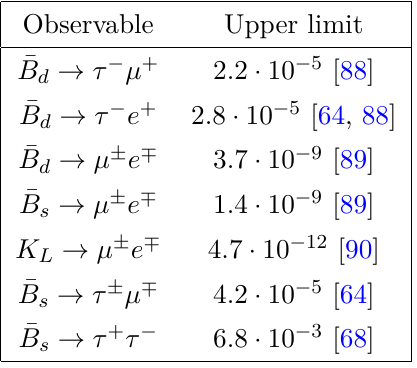
Table 3 . Experimental measurements of semileptonic LFV